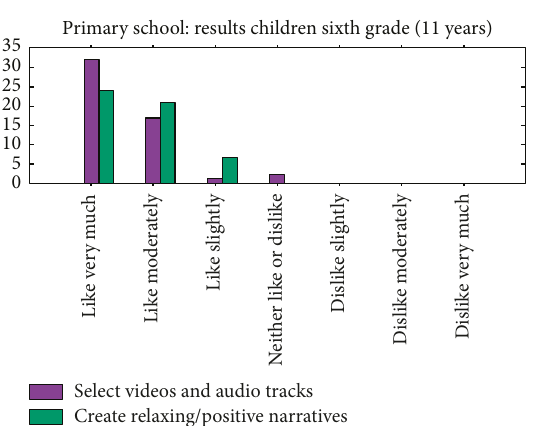
Figure 12: Results of the satisfaction survey for the second intervention in 6th grade for children aged 11 years (primary school).